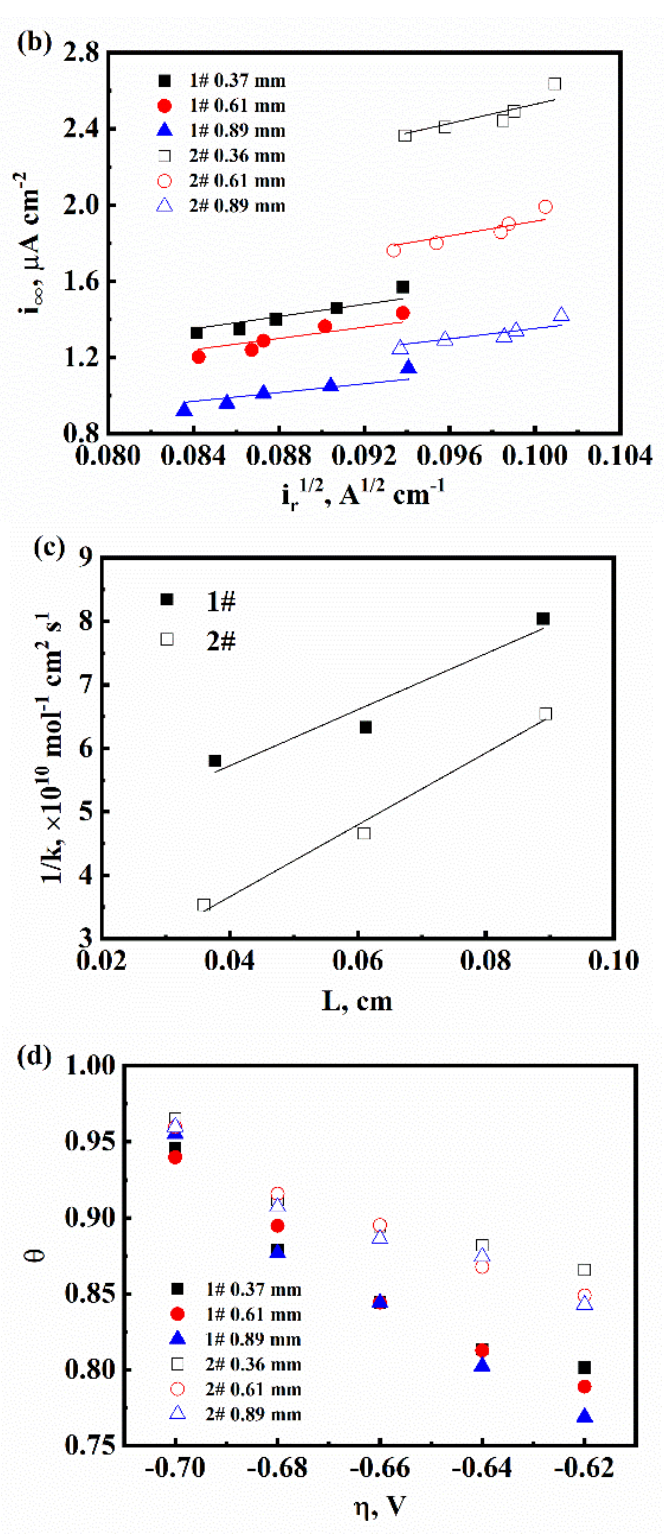
Figure 4. The characteristic of HER rate constants based on the IPZ model: (a) The relation between 𝑖 𝑐 exp( 𝐹 𝛼𝜂) and 𝑖 ∞ , the fitting results using Equation (4) are represented by the solid lines; (b) The relation between 𝑖 ∞ and 𝑖 𝑟1/2 , the fitting results using Equation (5) are represented by the solid lines; (c) The relation between 1/ k and the specimens’ thickness L ; the solid lines are the fitting results based on Equation (8); ( d ) The relation between the hydrogen surface coverage θ and the cathodic overpotential η